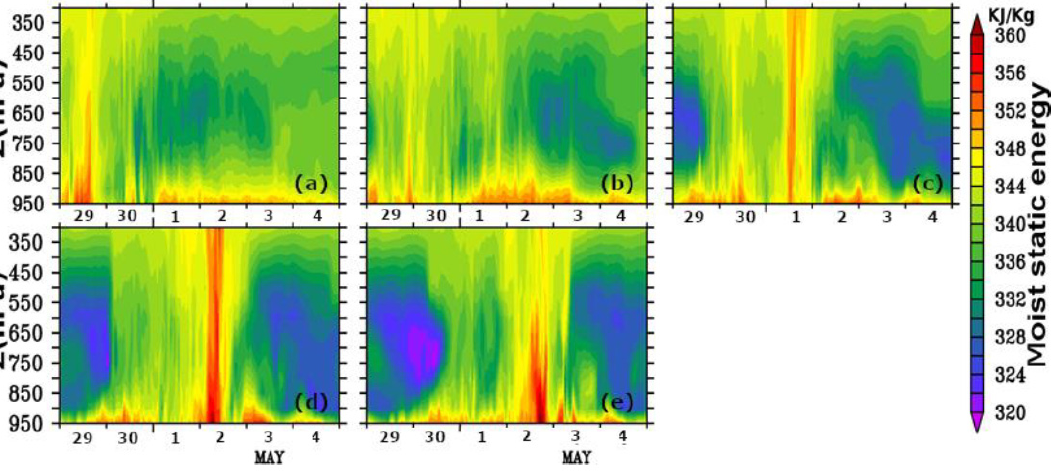
Figure 9. Model-simulated moist static energy (kJ kg − 1 ) over the locations A, B, C, D, E (marked in Figure 6) in panels ( a – e ),